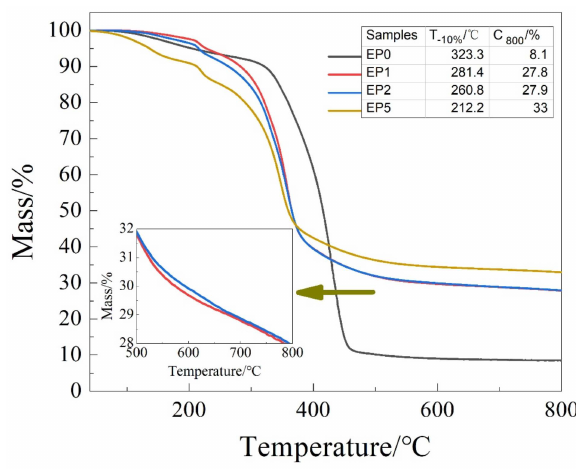
Figure 9. Thermogravimetric analysis curves of flame-retardant coating under N 2